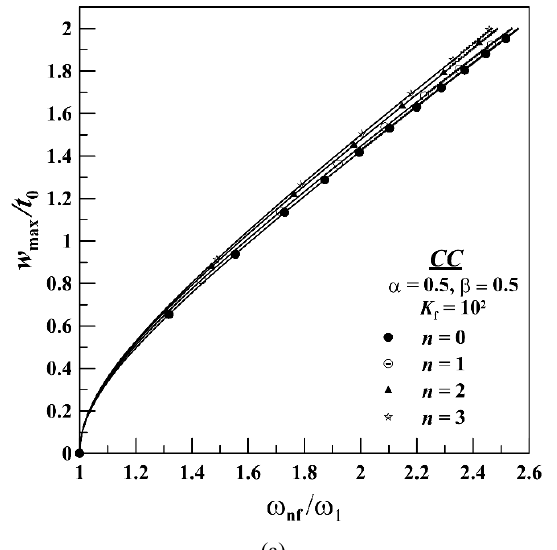
Figure 3. Backbone curves for different values of stiffness variation parameter for (a) CC beam, (b) CS beam, (c) SS beam.